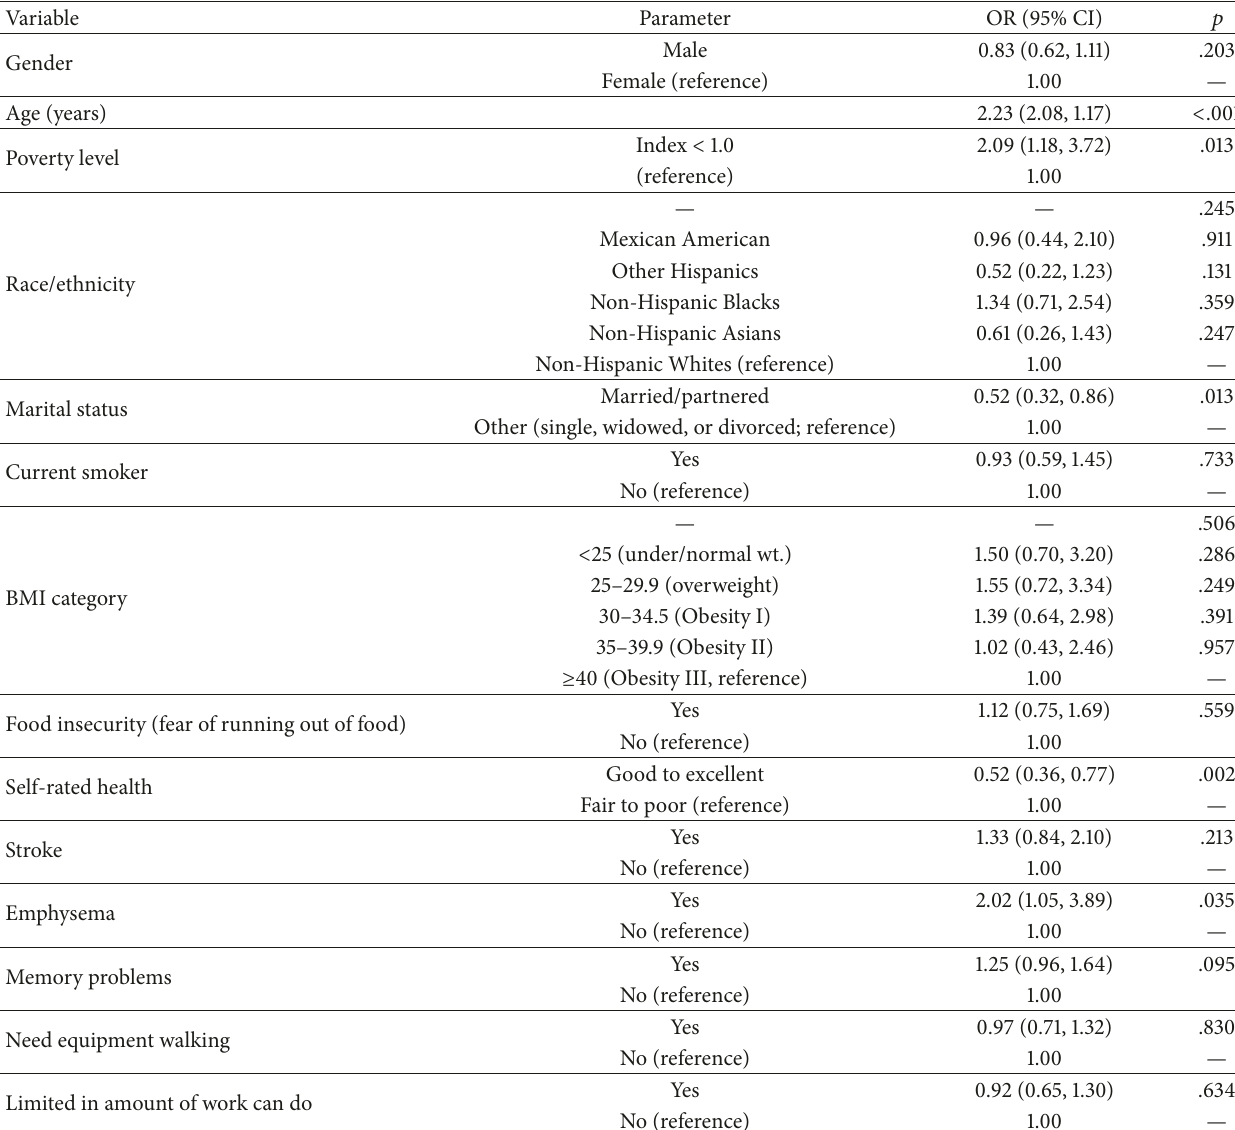
Table 3: Logistic regression analysis of demographics and health indicators for participation in OAA nutrition program compared to